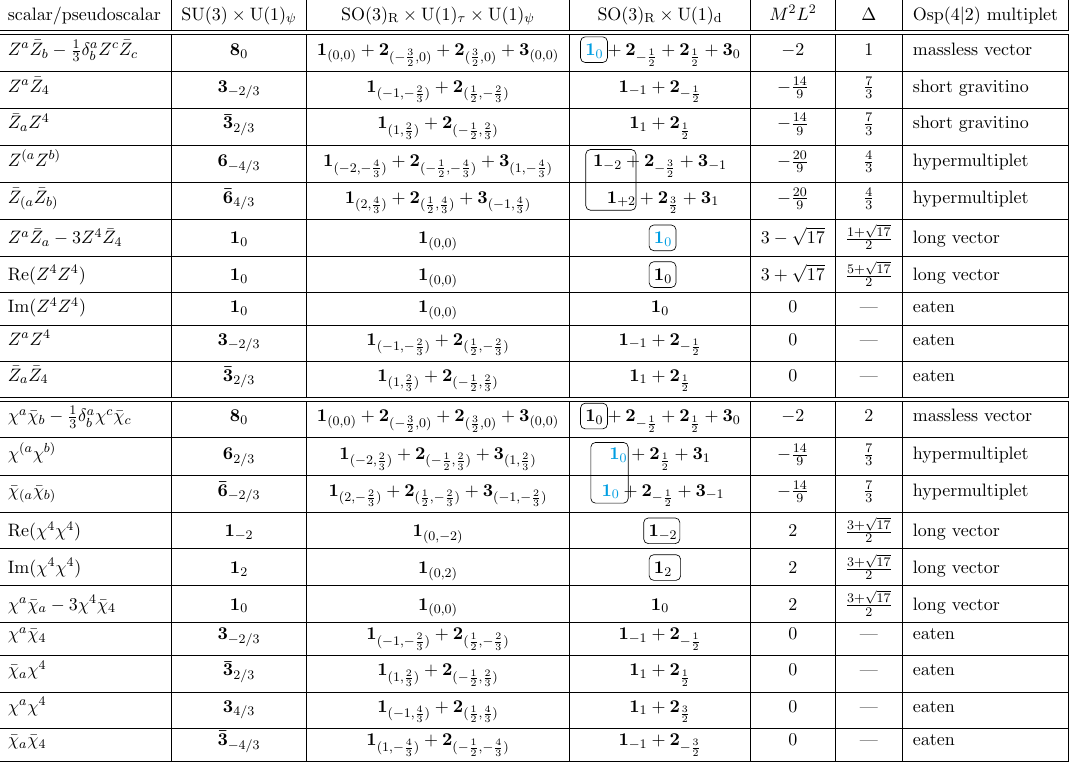
Table 5 . The scalar spectrum at the